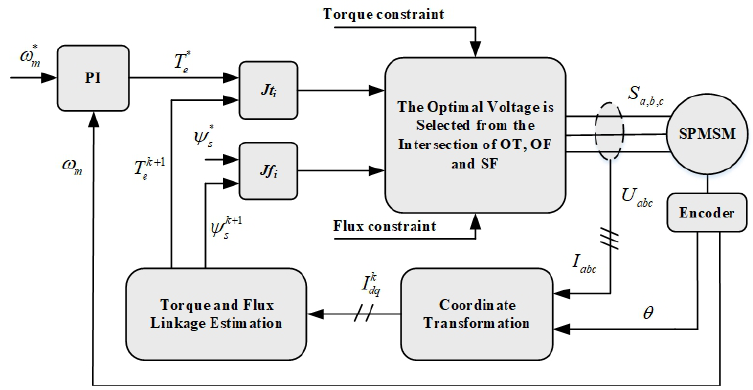
Figure 1. The control block diagram of PPTC.